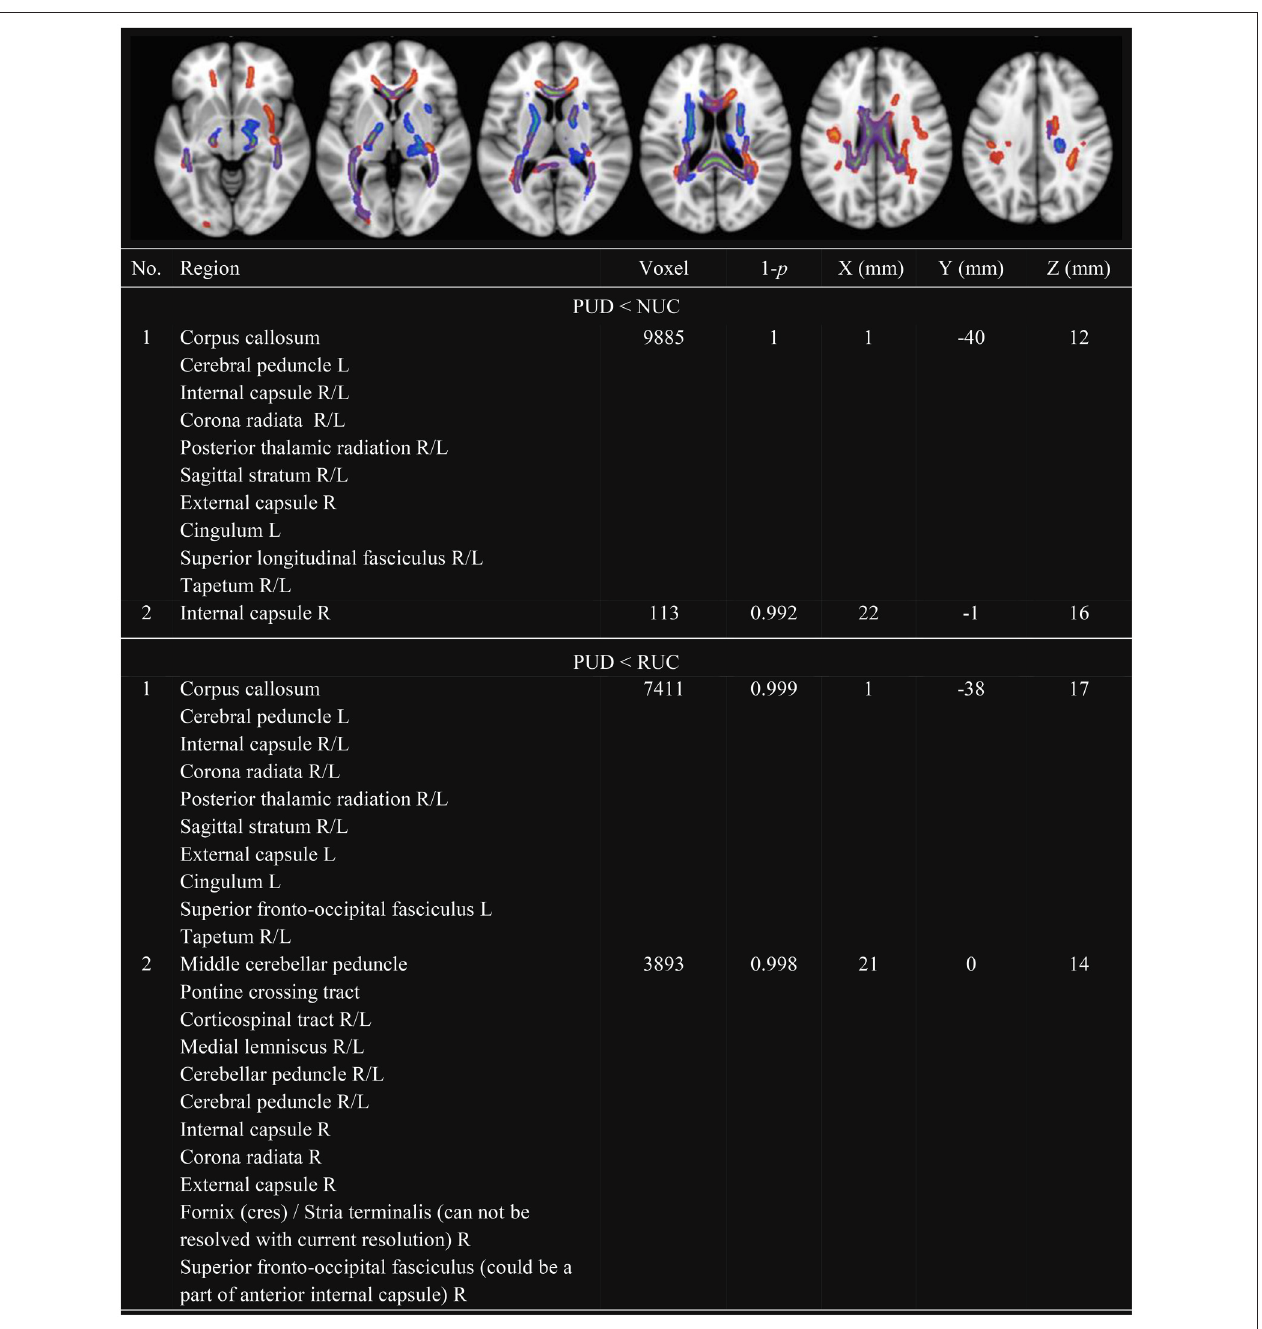
FIGURE 1 | Clusters with decreased FA in PUD compared to NUC and RUC. Only Clusters with a size more than 100 voxel are presented. FA, Fractional Anisotropy; NUC, Non-using controls; RUC, Recreational using controls; PUD, Poly-drug use disordered patients; PUD < NUC, Decreased FA in PUD in comparison to NUC (red-yellow); PUD < RUC, Decreased FA in PUD in comparison to RUC (blue-green); No., Number; Region, Included regions according to JHU ICBM-DTI-81 White-Matter Labels; R, Right; L, Left; Voxel; Number of voxel per cluster; 1- p, Statistical peak-value for each cluster; X–Y–Z (mm) = Peak-coordinates for each cluster. Significantly different clusters have been thickened with the FMRIB Software Library option